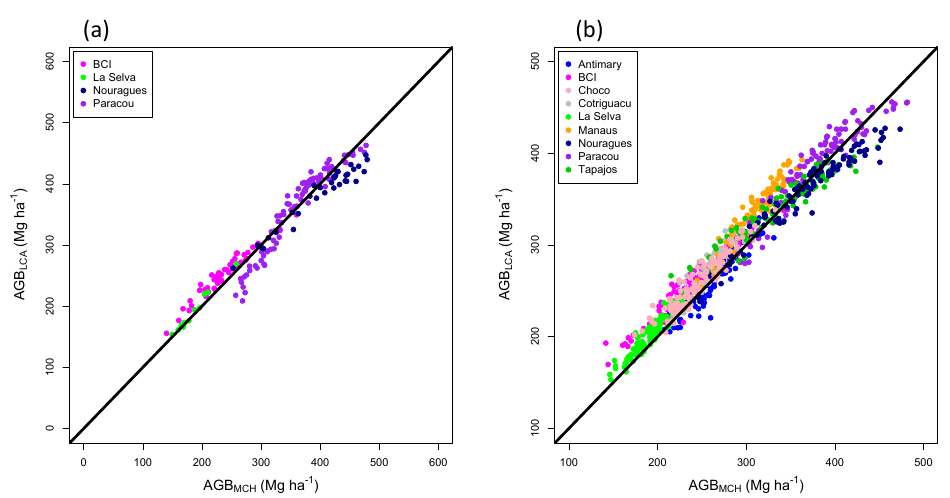
Figure 5. AGB MCH vs. AGB LCA in the plots of the four calibration sites (a) , and AGB MCH vs. AGB LCA in the 1km 2 images of the nine sites (b) . The black line represents the one-to-one